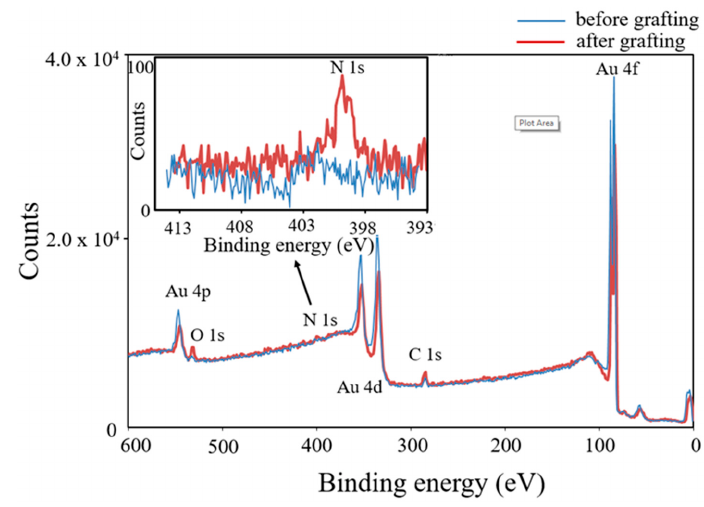
Figure 3. XPS spectra of gold surface before and after grafting with poly (2-(dimethylamino) ethyl methacrylate) (PDMAEMA). Inset: enlarged XPS spectra of N 1s region. N 1s signal appears after PDMAEMA grafting. Polymers 2020 , 12 , x FOR PEER REVIEW